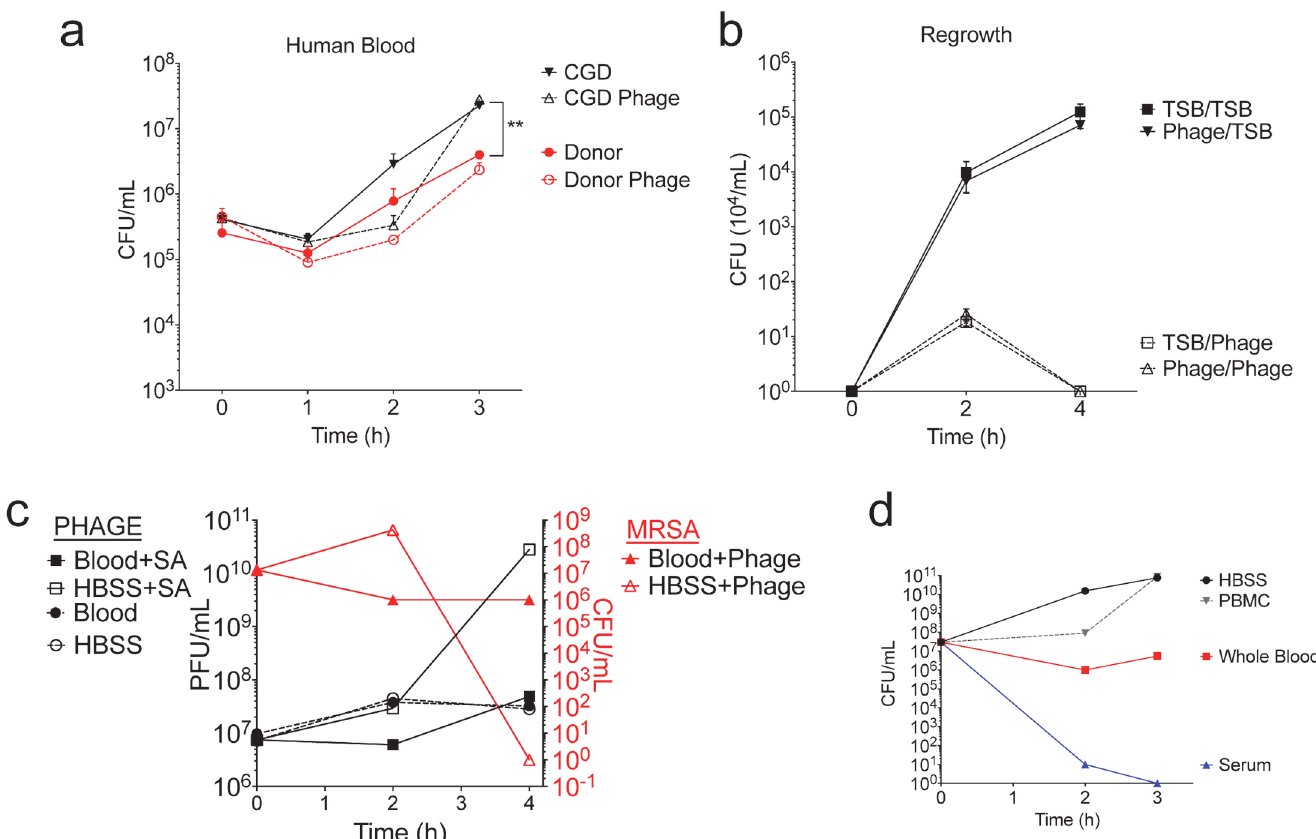
Fig 5. SATA-8505 Does Not Impact USA300 Growth in Human Blood. (a) Hourly quantification of starting culture of 10 6 CFU USA300 in three parts TSB and one part whole blood from healthy donor or a patient with CGD, grown with or without 10 8 PFU SATA-8505 in duplicate. (b) Regrowth of surviving colonies from whole blood culture run in triplicate. One colony of S . aureus previously grown in 3:1 TSB:Whole blood without phage was subsequently grown in TSB with SATA-8505 (TSB/Phage) or without phage (TSB/TSB); one colony of the surviving S . aureus previously grown in the presence of SATA-8505 was subsequently grown in TSB with SATA-8505 (Phage/Phage) or without phage (Phage/TSB). (c) Average quantification of starting culture of 10 10 CFU of USA300 grown in either 3:1 TSB:Whole blood or 3:1 TSB:HBSS, with or without 10 7 PFU SATA-8505. (d) Average quantification of starting culture of 10 7 CFU of USA300 grown in three parts TSB with either one part whole blood, HBSS, serum, or peripheral mononuclear cells (PBMC) in equivalent volume HBSS. Data shown are representative of 2 – 3 independent experiments using 3 or more different healthy volunteers and 2 patients with CGD. Data is displayed as mean + s.e.m. ** = p <